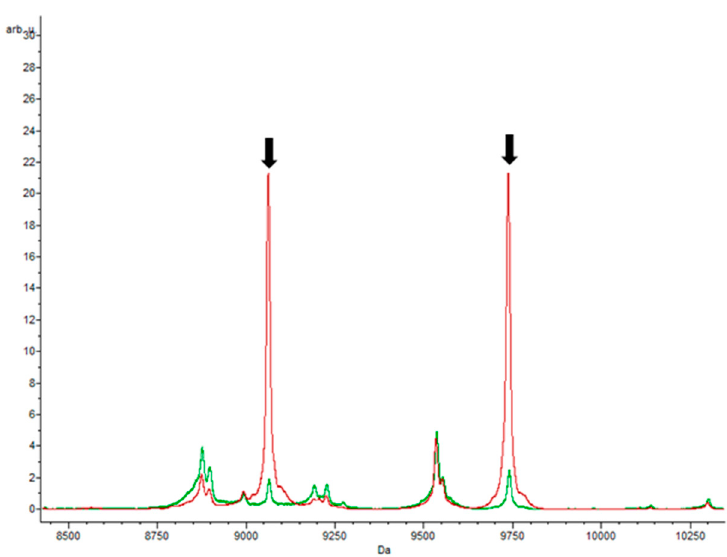
Figure 5. Peaks obtained with chloramphenicol. Spectra obtained in the presence of antibiotic (green) and without antibiotic (red). The results showed statistically significant peaks ( p -value = 0.000001), with masses of 9059.97 and 9735.29 m/z , respectively.